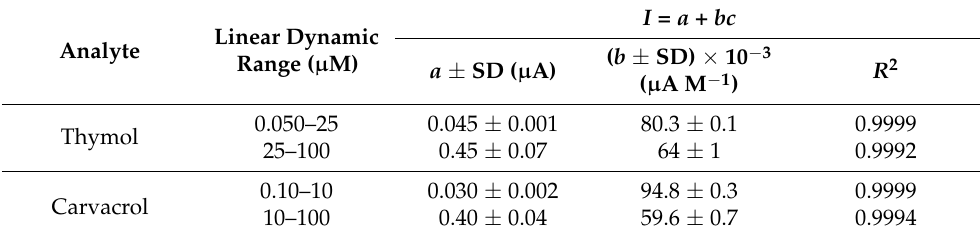
molphthalein/MWCNTs/GCE in Britton–Robinson buffer pH 2.0.